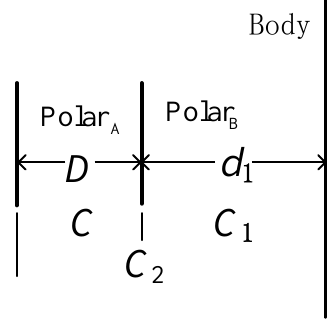
Figure 2. Relationship between the human body and the polar plates of the capacitor.